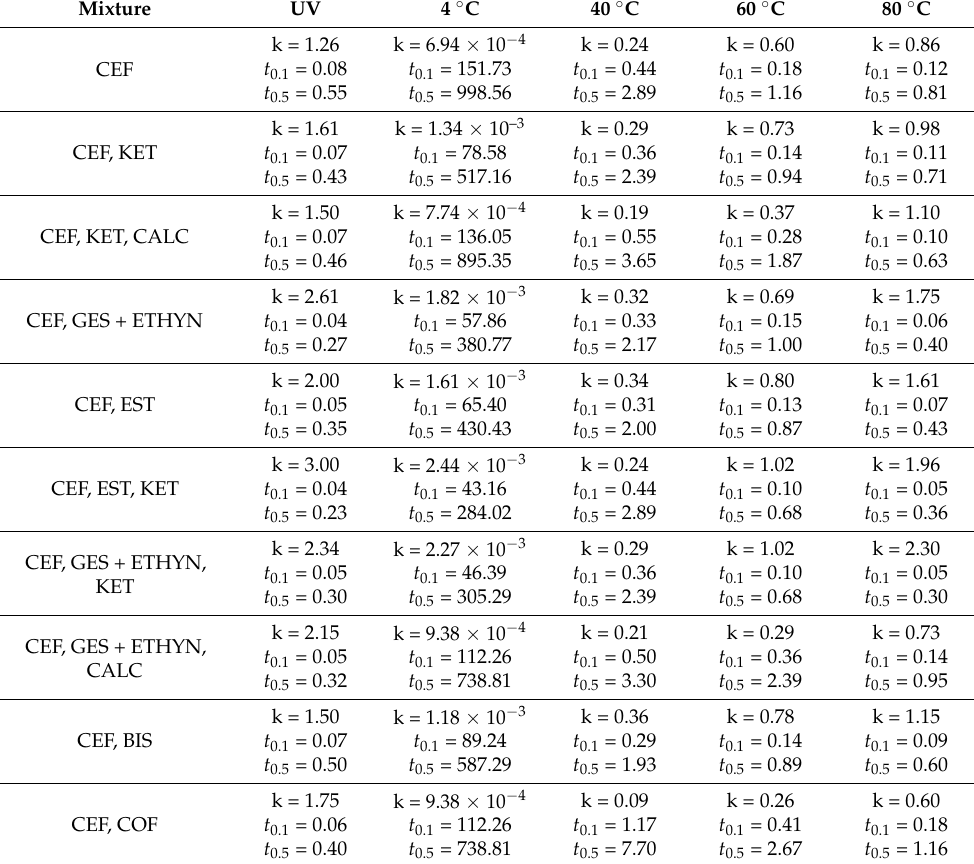
Table 7. Kinetics parameters designated for degradation processes of cefepime in various drug mixtures, under tested